Question: Is the quantity shown trending increasing or decreasing?
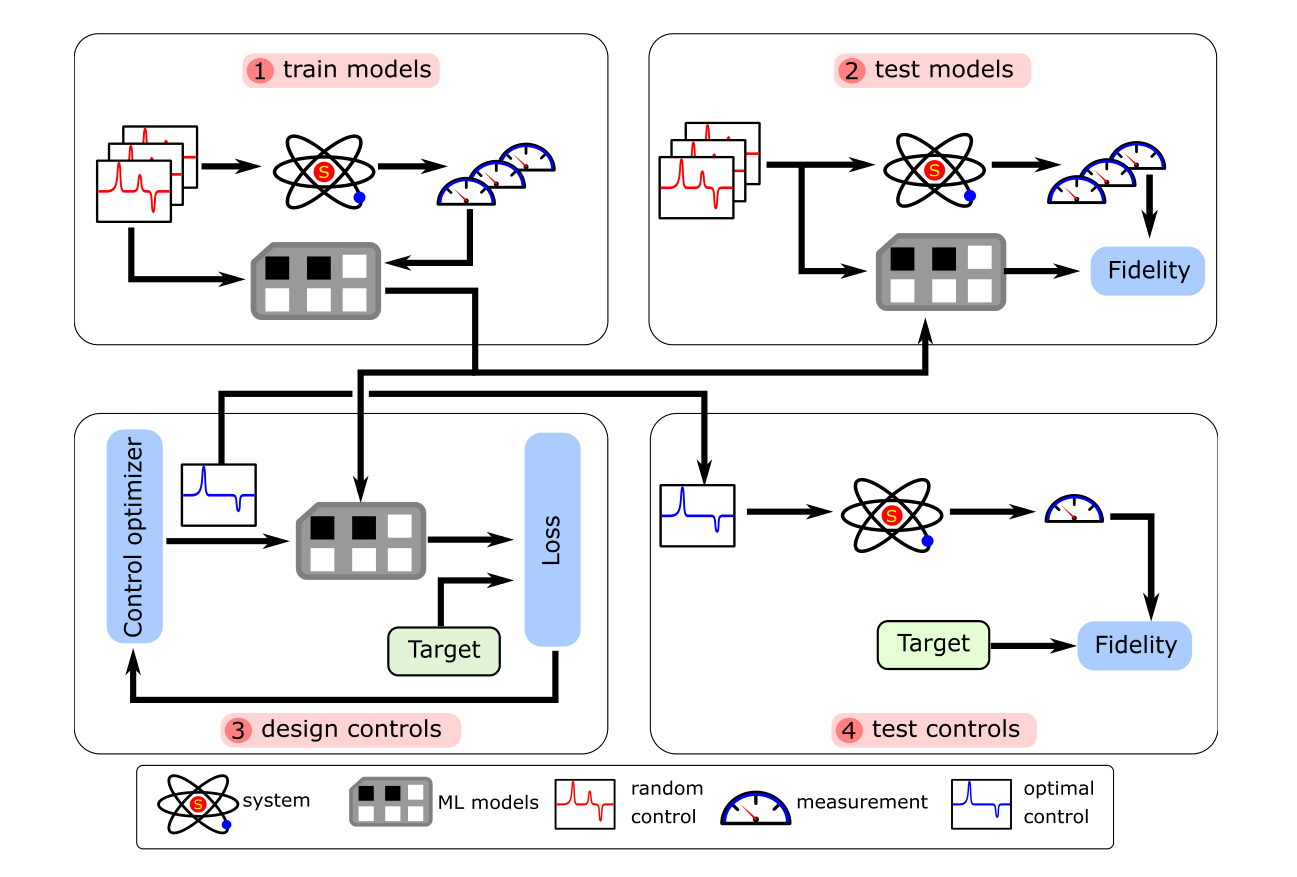
Answer: increasing